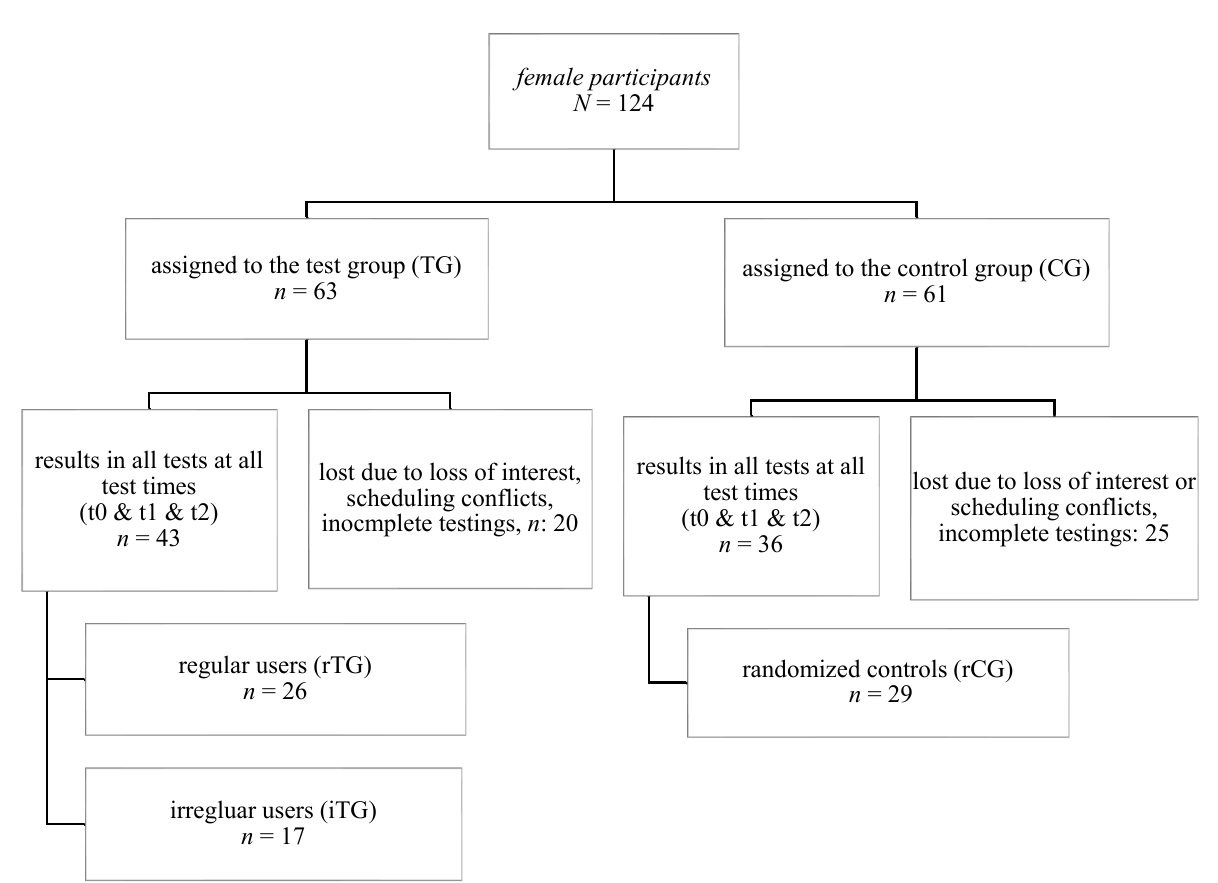
Figure 1. Flow of Participants Regarding Division Into Evaluation Groups / regular users used the system > 8 times per month, irregular users used it less than 8 times per month.